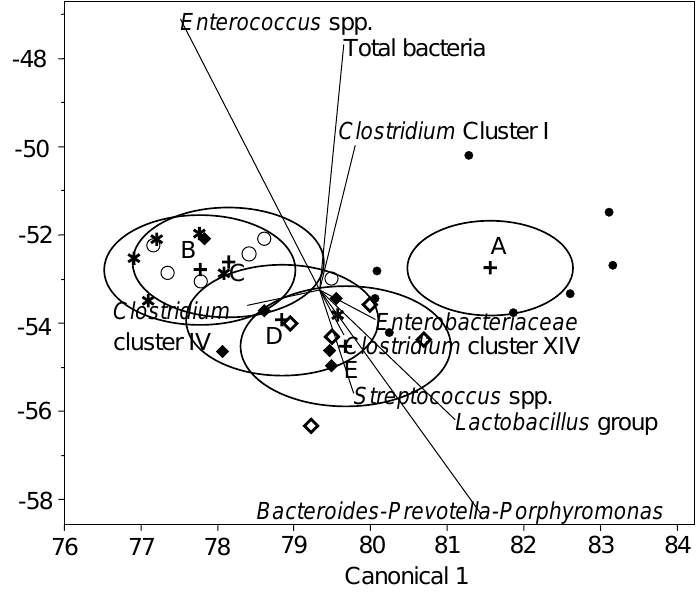
Figure 2. Linear discriminant analysis of the freeze-storage conditions and absolute bacterial abundances in feces. Circles indicate 95% confidence intervals. ( A ) DNA extraction from fresh fecal samples ( ), ( B ) from samples stored at −20 °C ( ), ( C ) from samples stored at −80 °C ( ), ( D ) from snap-frozen samples stored at −20°C ( ), and ( E ) snap-frozen samples stored at −80 °C ( ); n = 6.